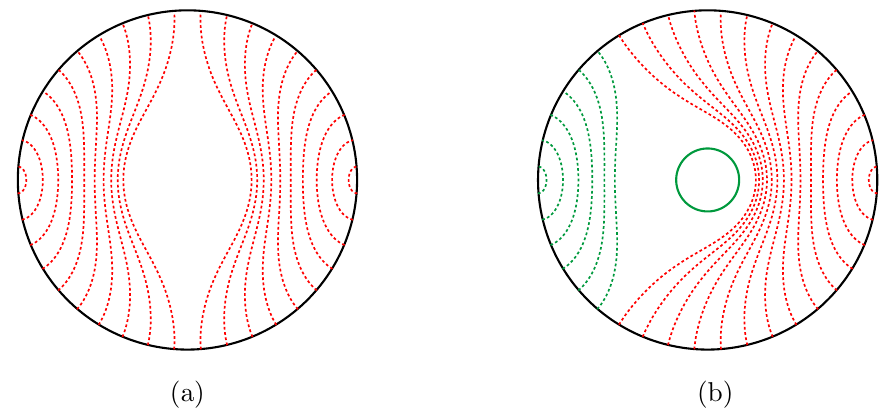
Figure 9 . Examples of bulk geometries wherein a boundary foliation does not generate a bulk foliation, in the sense that minimal surfaces leave behind ‘gaps’. (a) A hypothetical topologically and causally trivial ‘compact star’ geometry. (a) A black hole (BTZ) geometry, with horizon indicated by the thick green curve in the center. In both cases the dotted curves are globally minimal surfaces. However it the black hole case, in order to satisfy the homology requirement, the minimal surfaces for a large enough region ( (cid:0) ’ 0 ; ’ 0 ) consist of two disconnected components, the dotted green curve and the